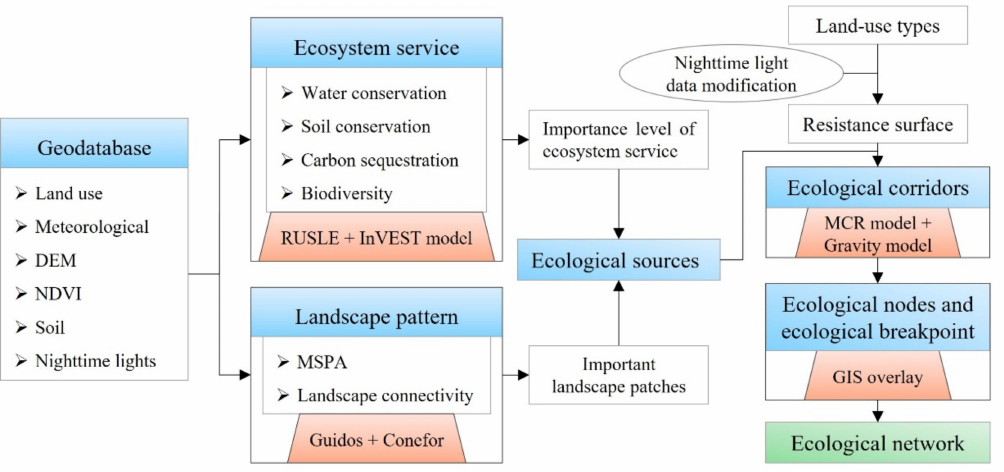
Figure 3. Logical framework and flowchart of this